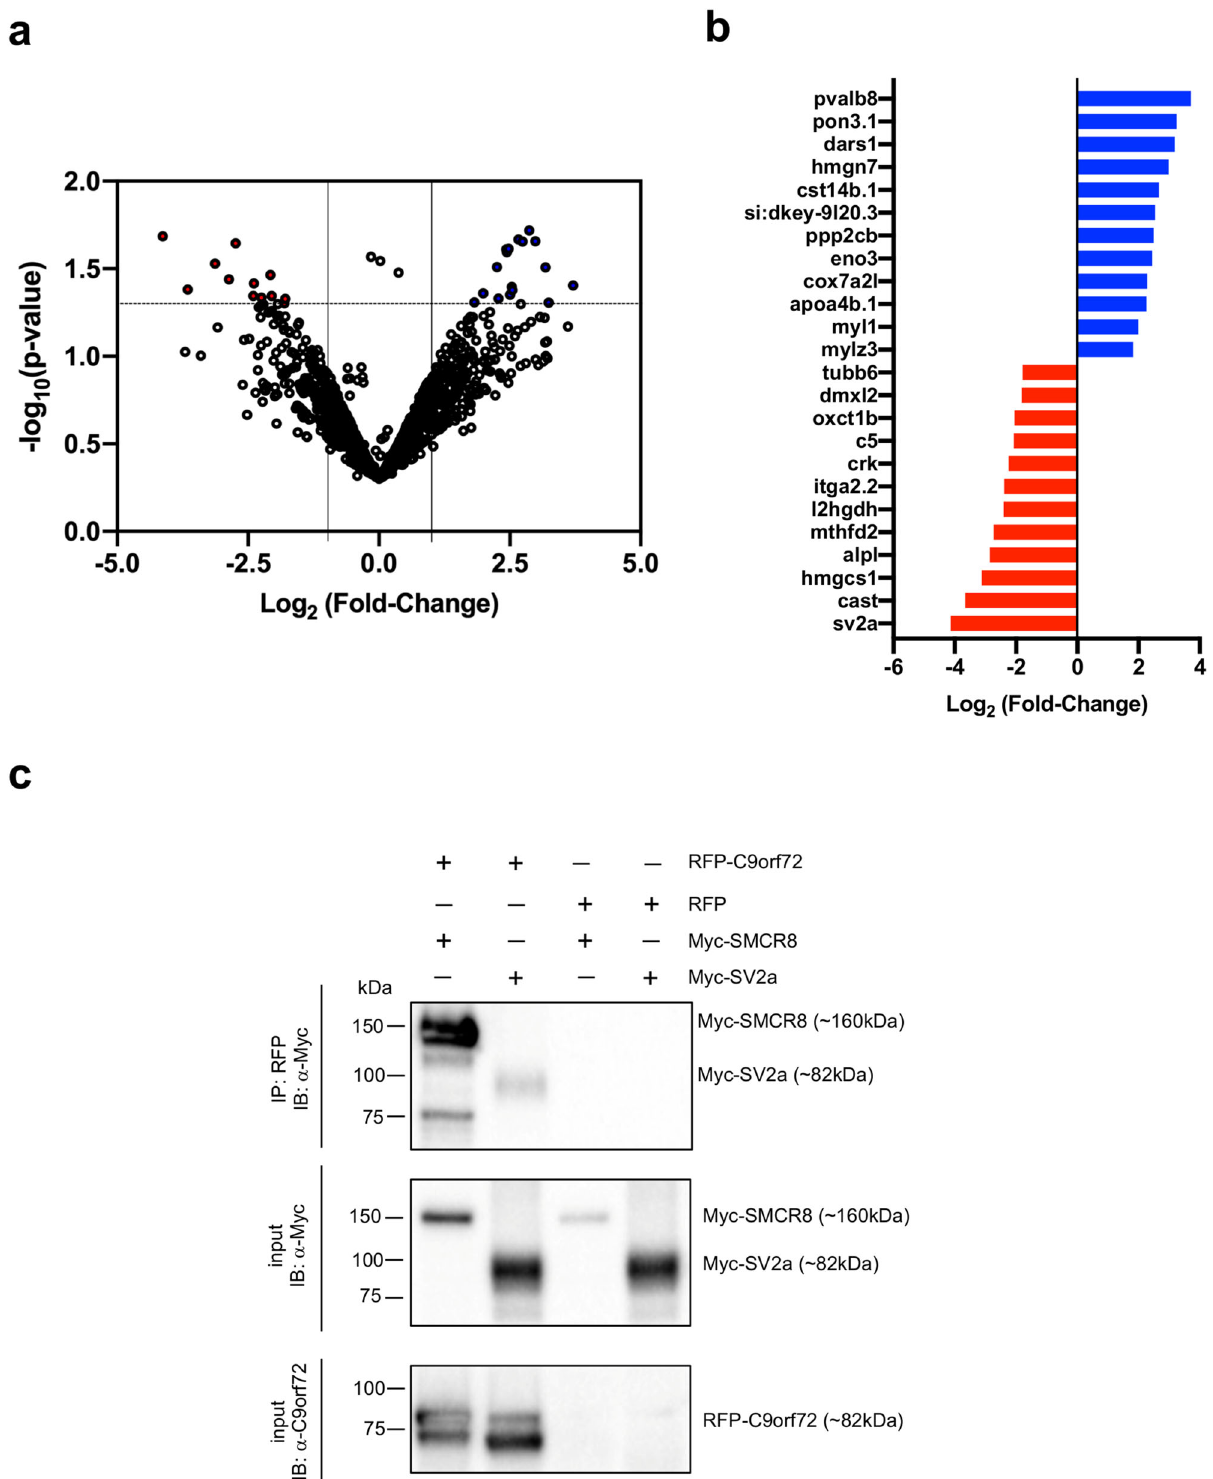
Fig. 7 Sv2a interacts with C9orf72 and its protein expression is downregulated in C9-miR fi sh. a Volcano plot showing the log2 fold change against the − log10 p value. Proteins in blue are upregulated while proteins in red are downregulated (log2 fold change of − 1.5 and 1.5, delineated by vertical lines) and are signi fi cantly dysregulated ( − log10 ( p value)> 1.301, delineated by horizontal dotted line) between control and C9-miR fi sh ( N = 4). b Differentially expressed proteins with p < 0.05 in C9-miR 6 dpf larvae ( N = 4). c Immunoblot analysis of RFP-immunoprecipitated proteins and lysate of HEK293T cells co-expressing RFP-tagged C9orf72 or RFP in combination with Myc-tagged SV2a or Myc-tagged SMRC8 (a known interactor of C9orf72; positive control). Myc-SV2a and Myc-SMCR8 were extracted out of solution in samples where RFP-C9orf72 was co-transfected, but not in samples where RFP was co- transfected ( N =